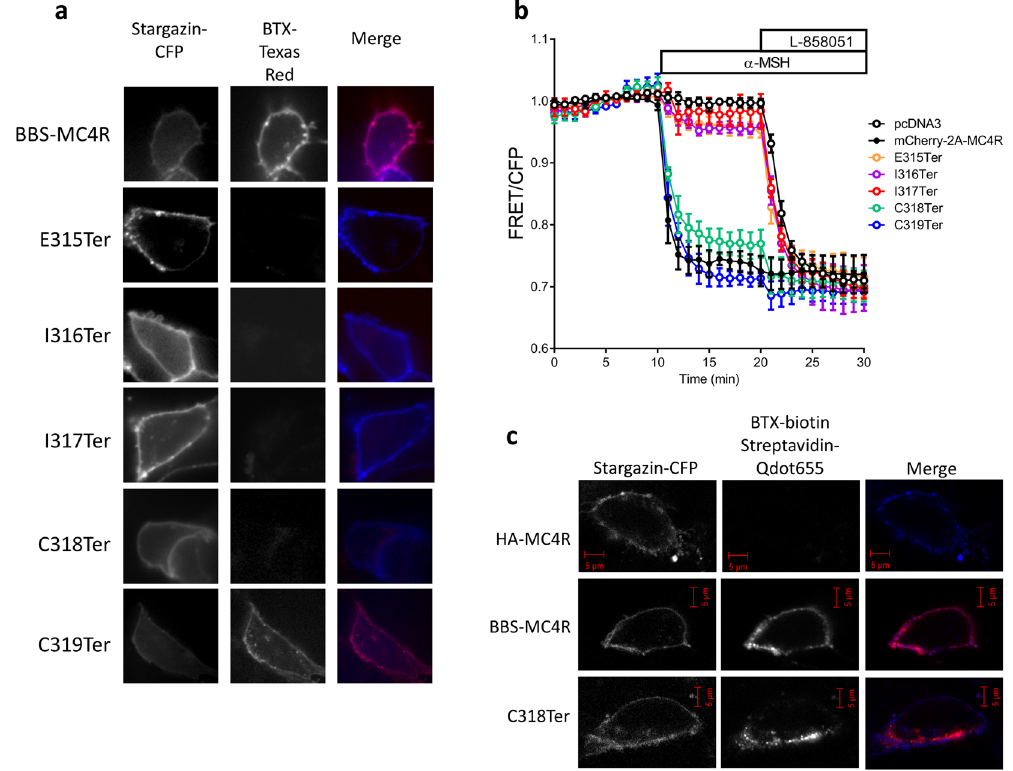
Figure 3. Truncation mutations in the 315 EIICC 319 region affect cell surface expression and signaling. ( a ) Cell surface localization, indicated by overlap with Stargazin-CFP which is a marker for the membrane, of bungarotoxin binding sequence (BBS)-tagged wild-type and truncated MC4R was observed using Texas Red conjugated bungarotoxin. WT and several truncation mutants are observed robustly on the cell surface, while truncations prior to C318 are not. Stargazin-CFP expression is used to label the plasma membrane. ( b ) cAMP production depicted as reduced FRET in HEK293 cells expressing the EPAC sensor as well as either the wild-type or C-terminal truncation mutants of MC4R. Stimulation with MC4R agonist α -MSH (100 nM) results in robust changes in FRET for the WT and truncations after C318, while mock transfected cells and those expressing truncations before C318 did not respond to α -MSH. The cyclase activator L-858051 (100 µ M) was added at the end to activate maximum cAMP response. These data represent the mean ± S.E.M. of three independent replicate experiments where at least 10 cells were imaged per replicate. ( c ) Cell Surface expression of C318Ter truncation labeled with bungarotoxin-streptavidin and biotin-Qdot655 for brighter signal showing presence of C318Ter on the cell surface that seems to be more transient and therefore more difficult to capture during imaging.